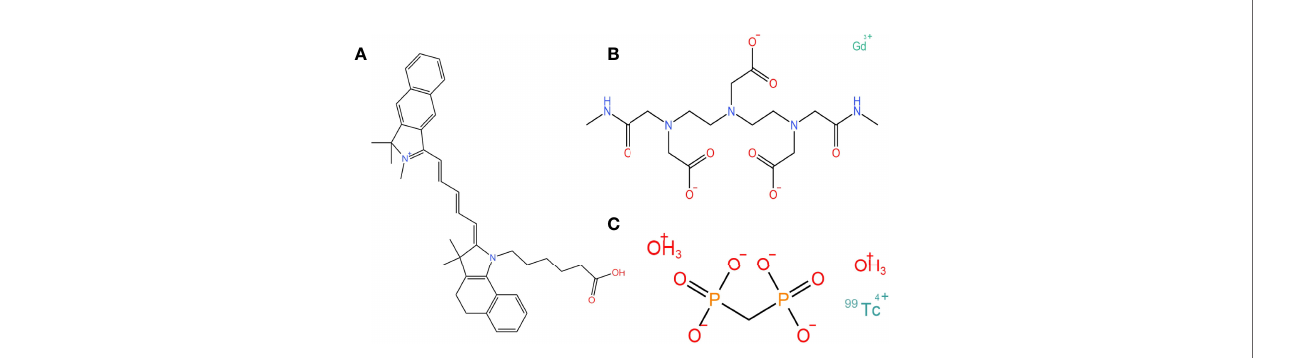
FIGURE 2 | The chemical structure of fl uorescence, magnetic, and SPECT nanoparticles that can compose multimodality probes. (A) A fl uorescent dye: Cy5.5 carboxylic acid. (B) A magnetic nanoparticle as molecular imaging agent: gadodiamide. (C) A SPECT-CT tumor imaging agent: technetium